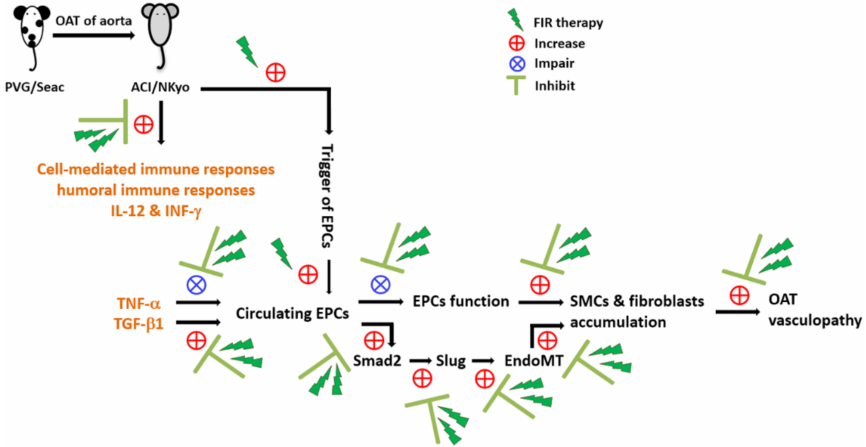
Figure 7. FIR therapy may effectively regulate chronic rejection-induced vasculopathy in OAT rats. Therapy of FIR reduced T and B lymphocytes, plasma cells, and macrophage activation in the